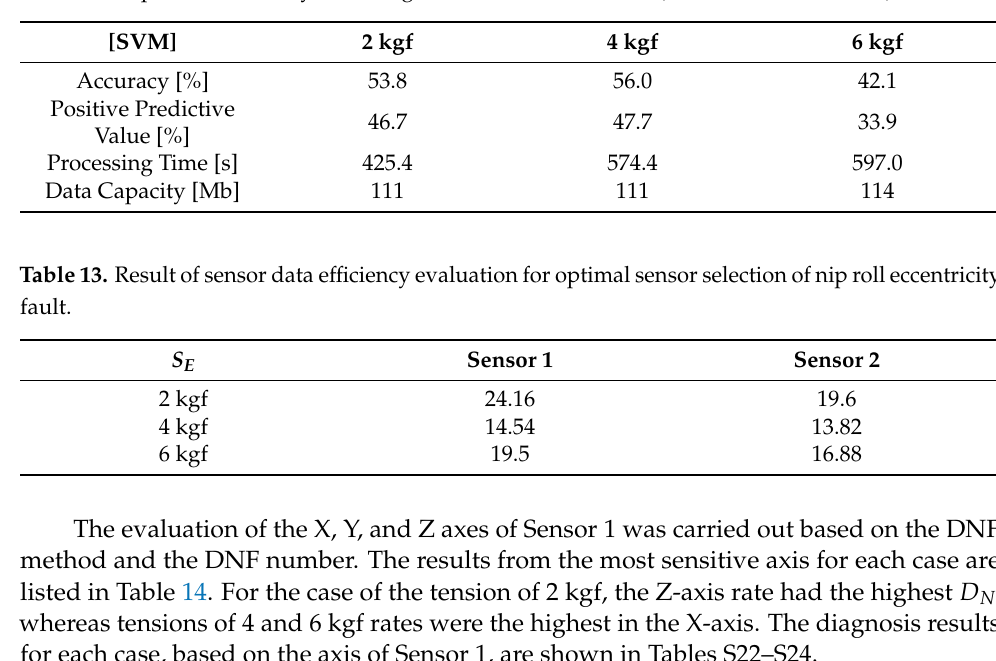
Table 14. DNF Number of axis X, Y, and Z from Sensor 1 of nip roll eccentricity fault. D N X Axis Y Axis Z Axis 2